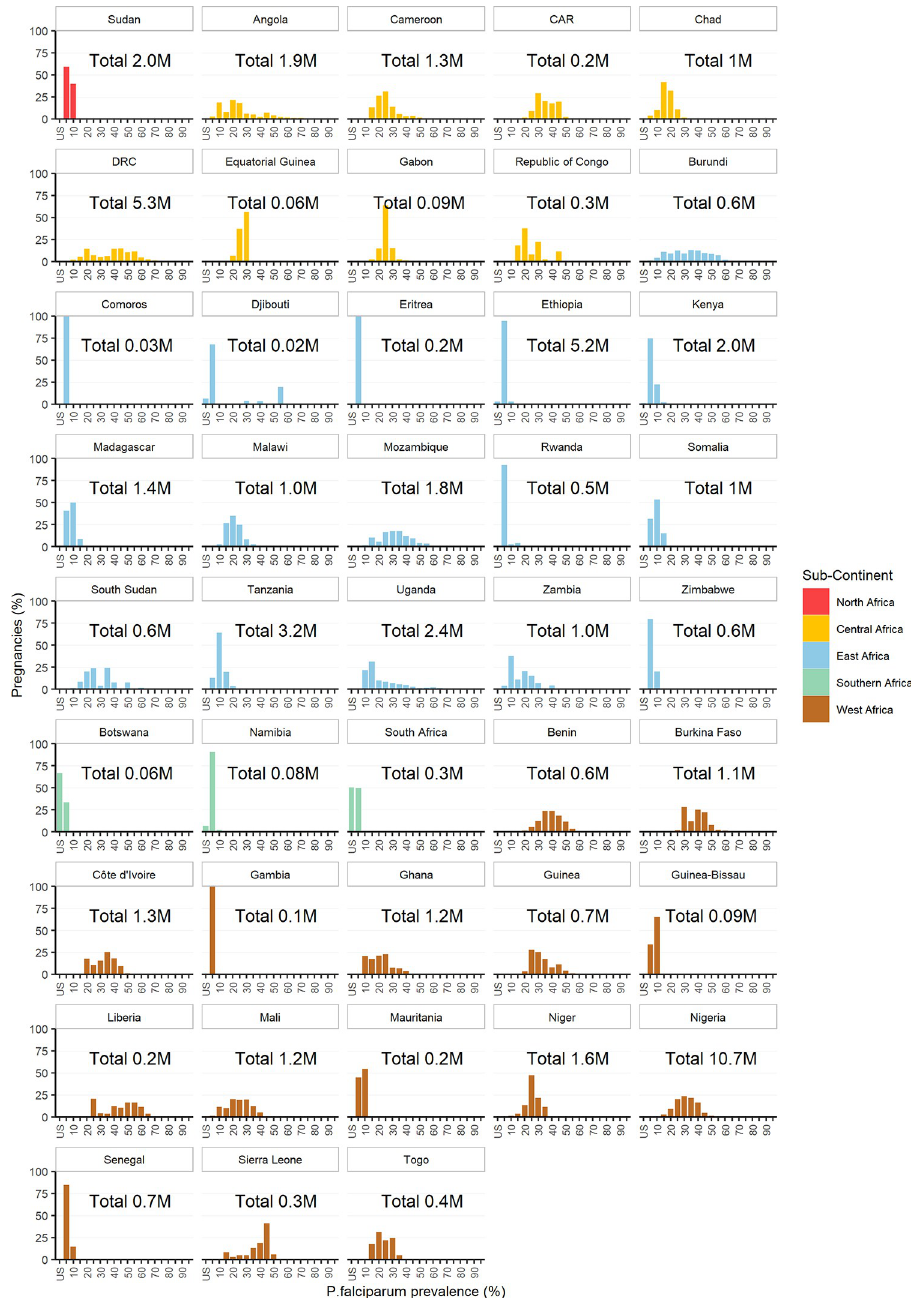
Fig 1. Proportion and total number of pregnancies at risk of Plasmodium falciparum in Africa in 2020 by country and prevalence (%); US = unstable (0 > and < 0